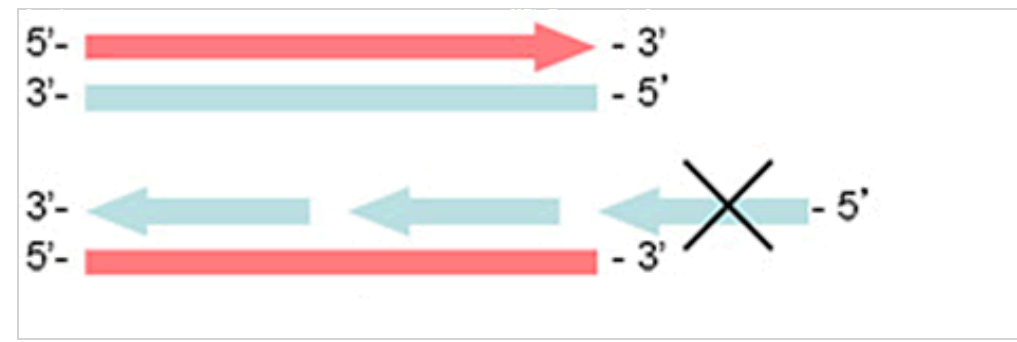
Figure 1. The 'end-replicaon problem' in linear